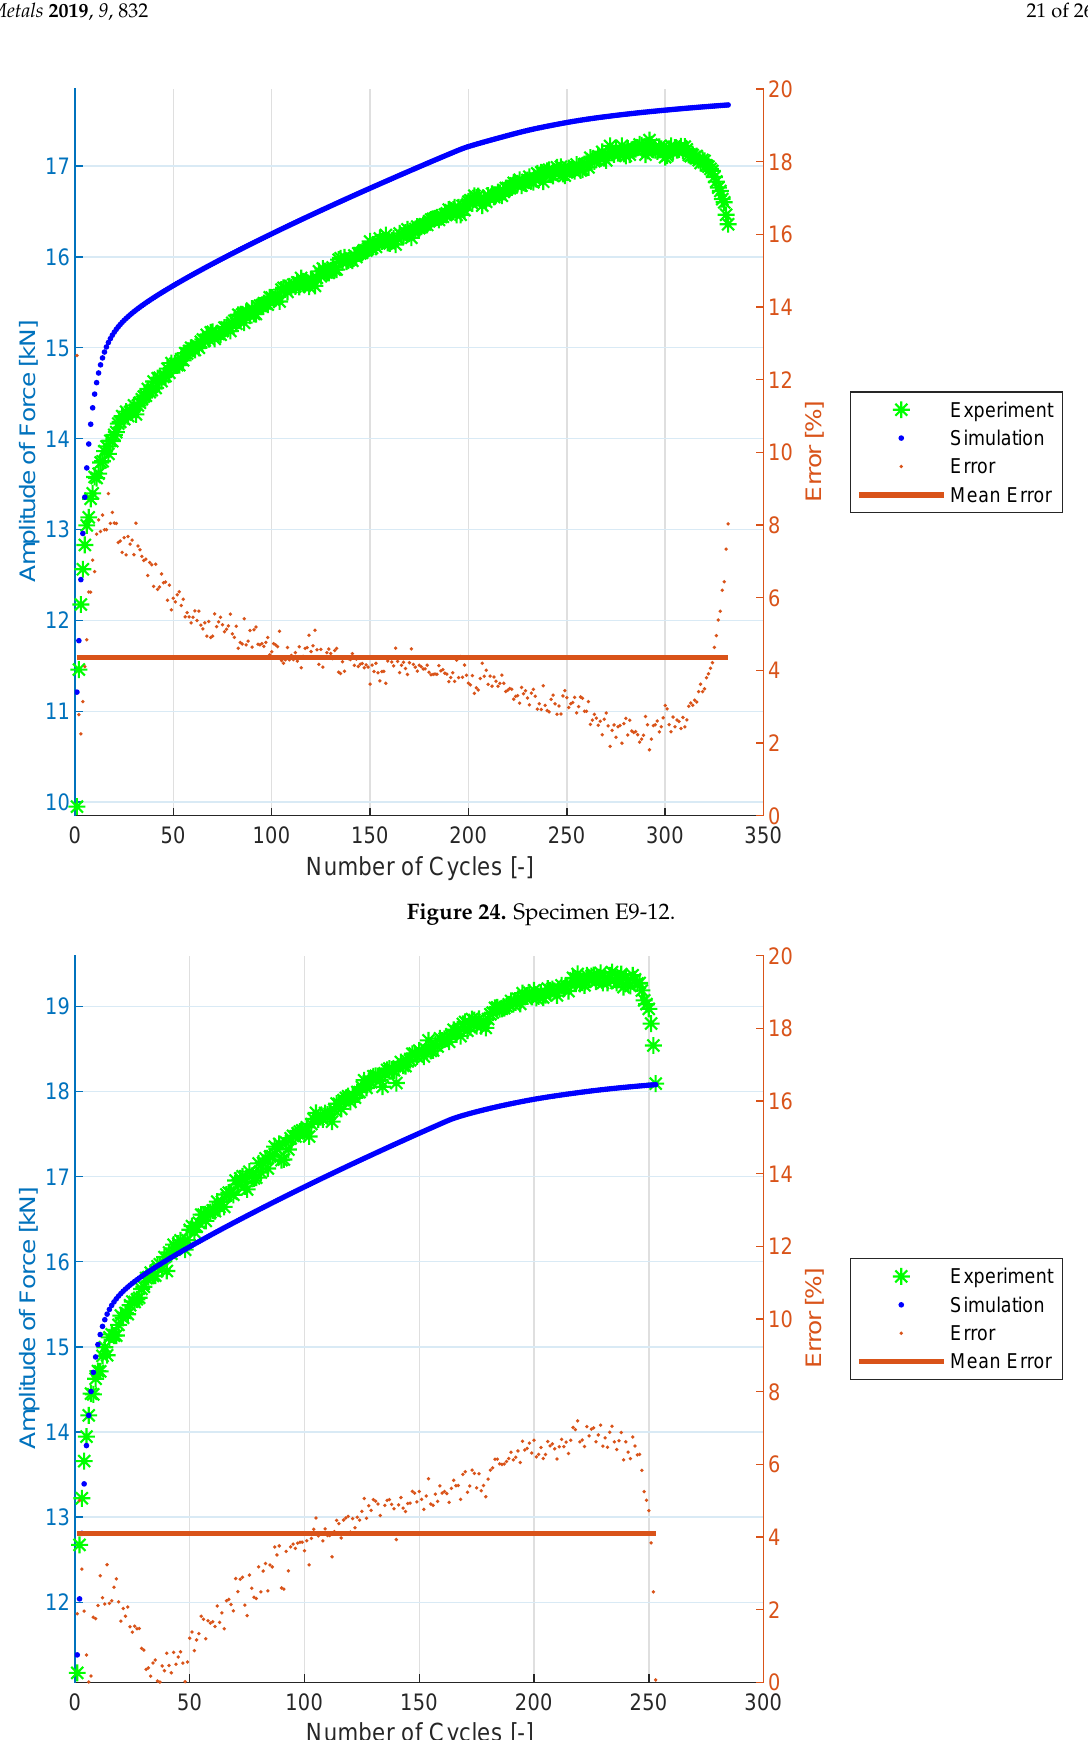
Figure 24. Specimen E9-12.